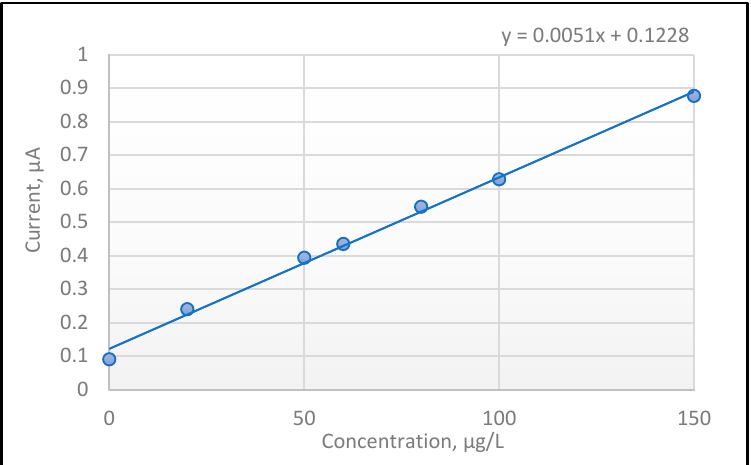
Figure 3. Linear regression curve for Hg(II) through the DPV technique with SPE-poly L .